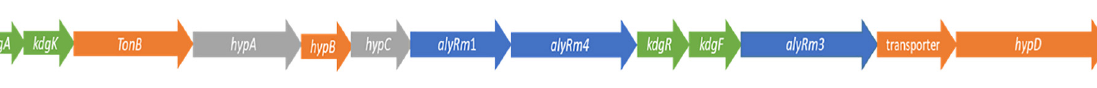
FIGURE2 Alginate polysaccharide utilization locus (Alg-PUL) in R. marinus MAT378 containing the alginate lyase genes alyRm1 , alyRm3 and alyRm4 . Annotation of the genes from left: kdgA (642 nt) encoding putative 4-hydroxy-2-oxoglutarate aldolase; kdgK (1,026 nt) encoding putative 2- dehydro-3-deoxygluconate kinase; tonB (2,805) TonB dependent receptor; hypA (2,181 nt) encoding T9SS type A sorting domain-containing protein; hypB (1,056 nt) encoding PorV/PorQ family protein; hypC (1,398 nt) encoding hypothetical protein; alyRm1 (1,743 nt) encoding alginase; alyRm4 (2,253 nt) encoding exo-alginase; kdgR (759 nt) encoding 4-hydroxy-2-oxoglutarate reductase; kdgF (357 nt) encoding cupin domain-containing protein. The kdgR (759 nt) and kdgF (366 nt) have been verified as genes encoding 4-deoxy- L - erythro -5-hexosulose uronate (DEHU) reductase and an enzyme catalyzing linearization of unsaturated uronates from alginate, respectively; alyRm3 (2,673 nt) encoding endo-alginase; transporter gene (1,278 nt) encoding predicted mannuronate transporter; hypD (2,844 nt) encoding PD40 domain-containing protein. The colors of arrows indicate the functional role. Blue arrows; enzyme involved in degradation of alginate and production of uronic acids; Orange arrows: transport; Green arrows: enzymes for Entner Douderoff (ED) glycolytic processing of uronic acids. Gray arrows: hypothetical